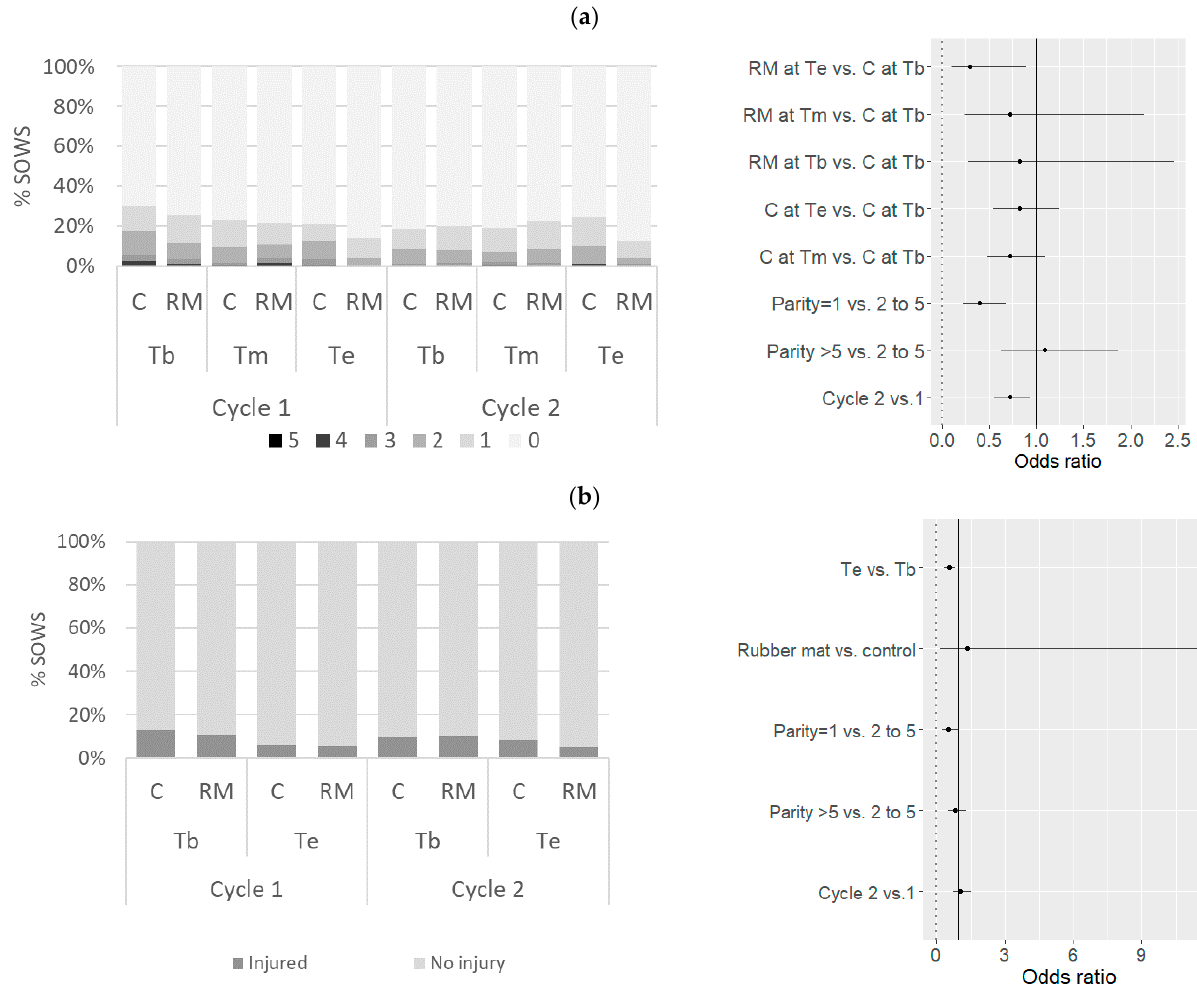
Figure 3. Frequencies of observed ( a ) bursitis and ( b ) leg injuries and estimated odds ratios (with 95% confidence intervals) according to the floor type and gestation cycle, from the beginning (Tb) to the middle (Tm) and end (Te) of the gestation period. RM, rubber mat; C, control.